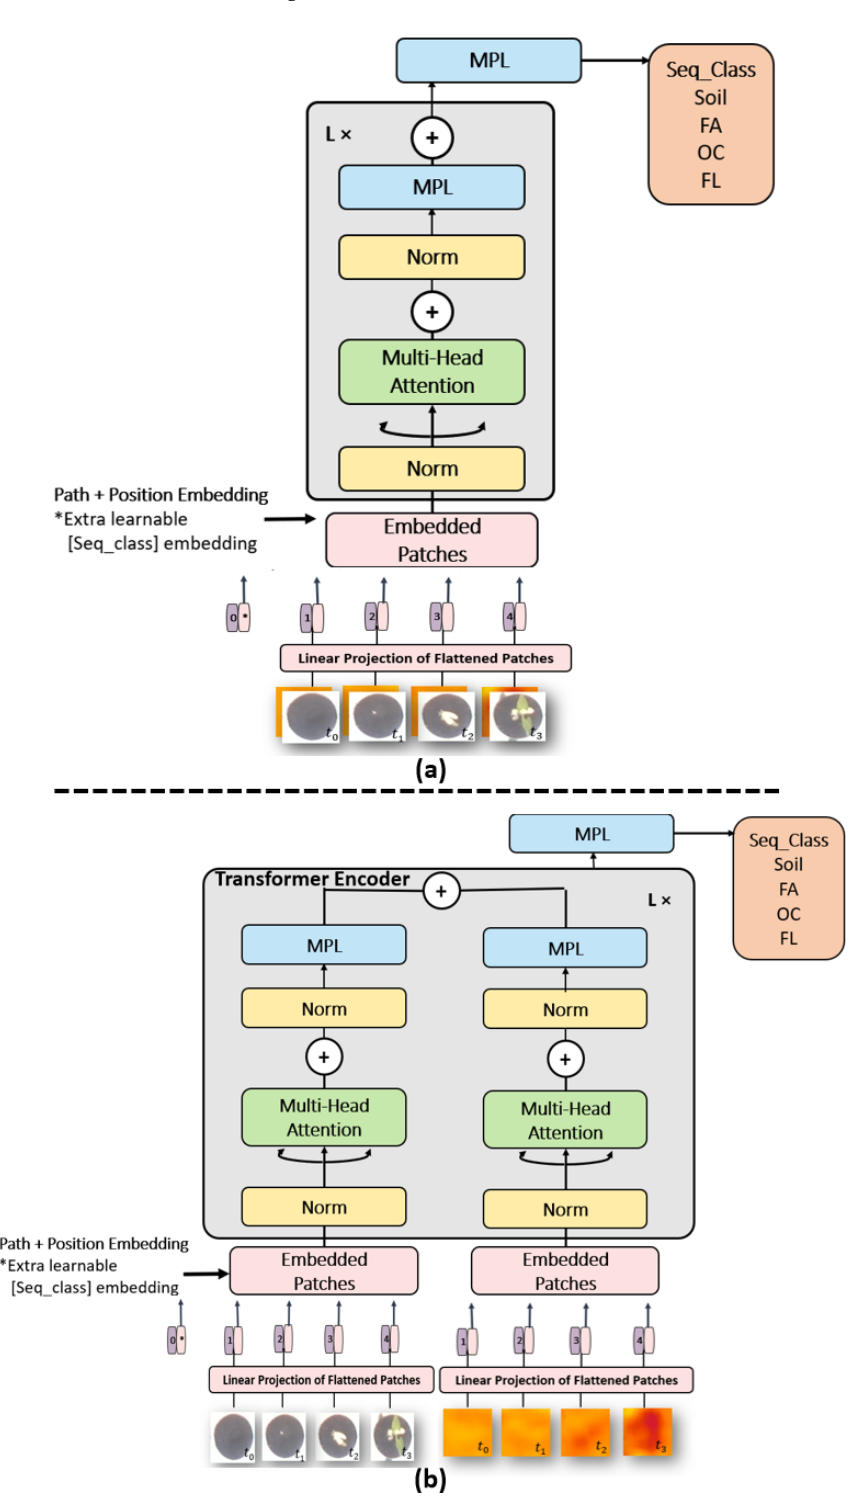
Figure 5. ( a ) Transformer architecture of image fusion for RGB-Depth, ( b ) Transformer architecture of features fusion for